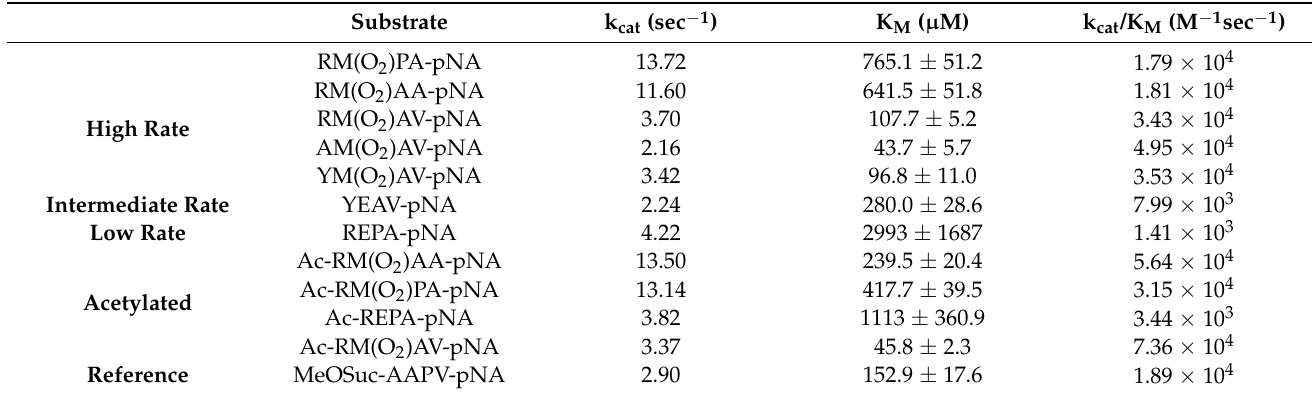
Table 1. Kinetic constants calculated for candidate HNE pNA substrates. Substrates in each section are sorted by descending k cat values. K M values are listed ± SEM.